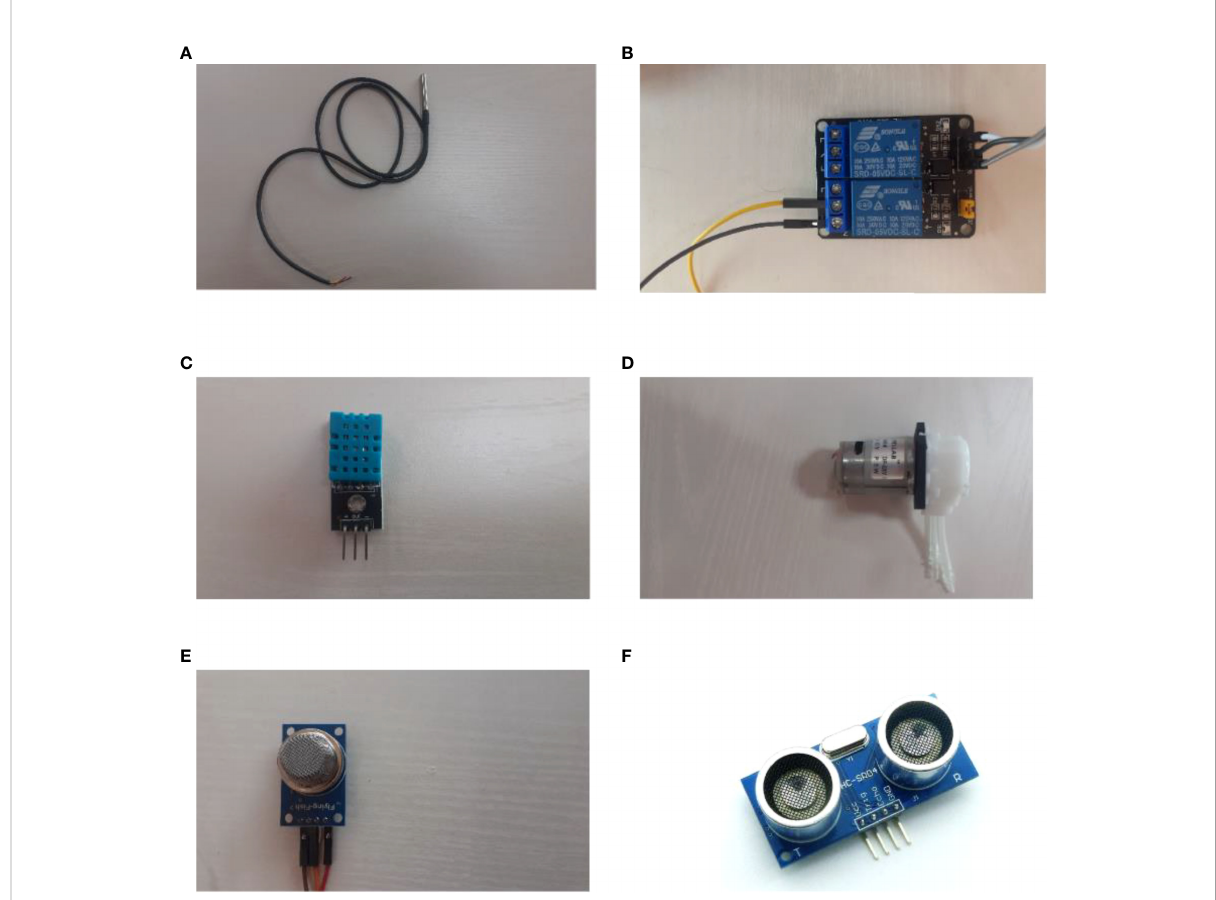
(cid:129) Figure 5E showcases the MQ135 CO2 gas sensor, an air quality sensor for detecting a wide range of gases, including NH3, NOx, alcohol, benzene, smoke, and CO2 (Abbas et al., 2020). For our platform, we have used MQ135 to measure CO2 concentration in ppm. (cid:129) Figure 5F shows the ultrasonic sensor, which measures the distance to an object using ultrasonic sound waves with high reliability (Latha et al.,